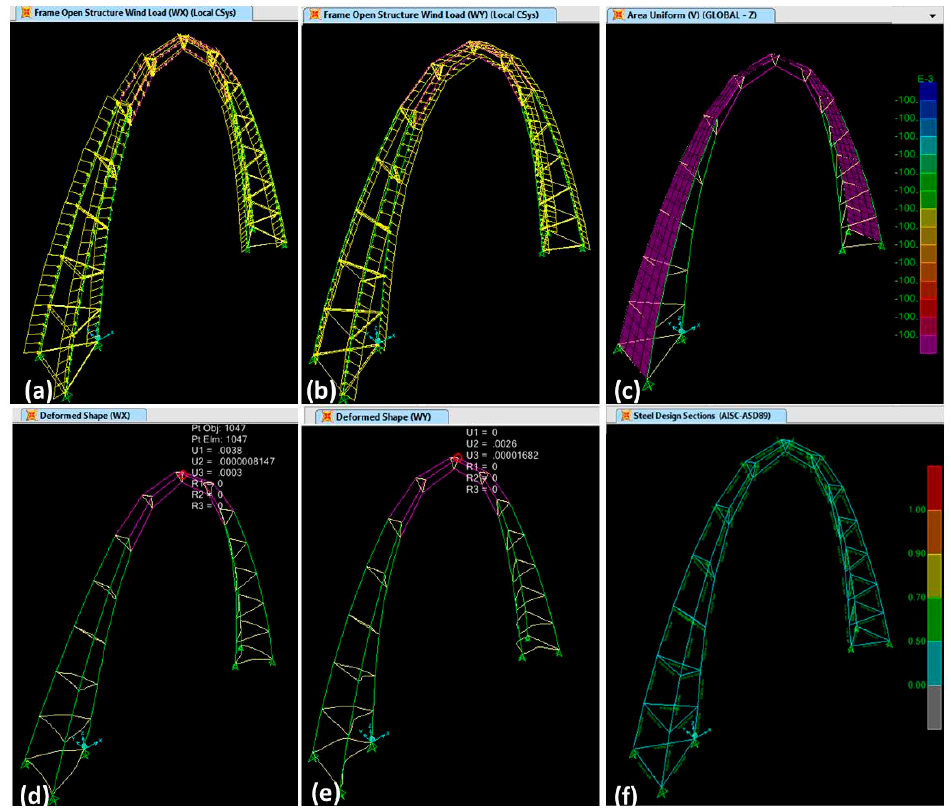
Figure 31. Digital analysis of the system under own weight, wind loads and shell load of 100 kg / m 2 . ( a ) The in-plane wind loads. ( b ) The out-of-plane wind loads. ( c ) The applied shell load ( d ) Deformation resultant from the in-plane wind loads. ( e ) Deformation resultant from the out-of-plane wind loads. ( f ) Design is safe.